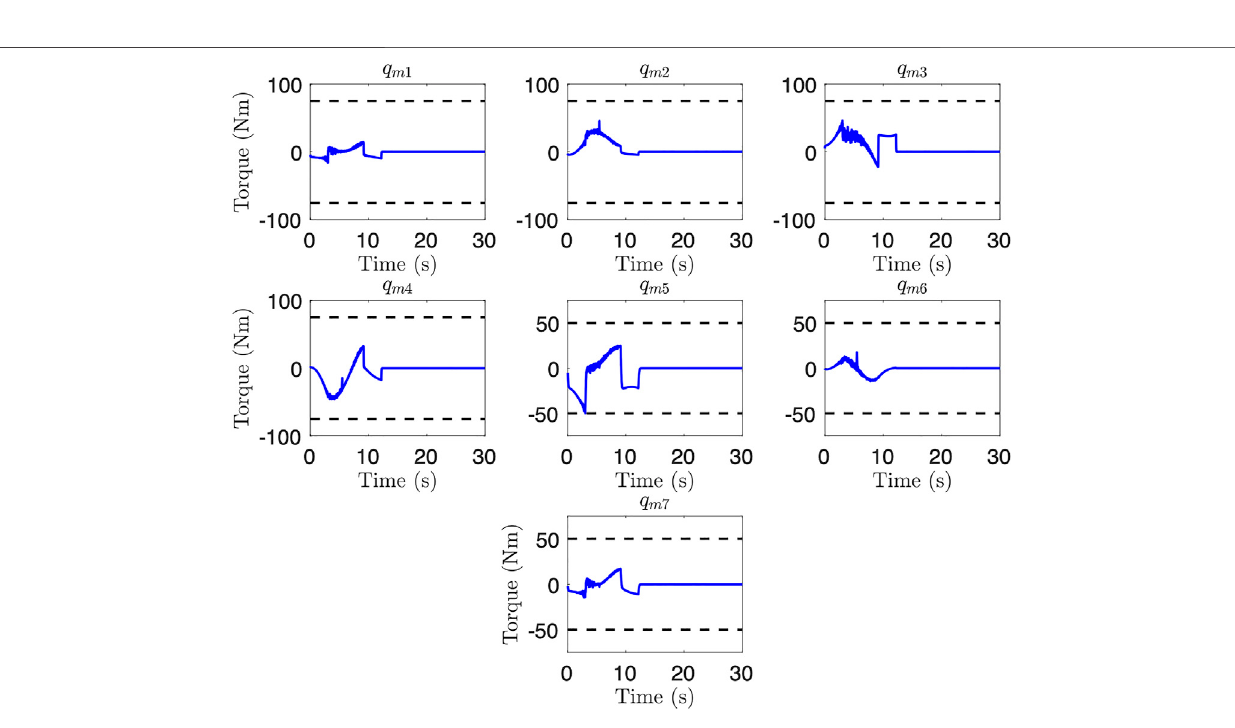
Frontiers in Robotics and AI |